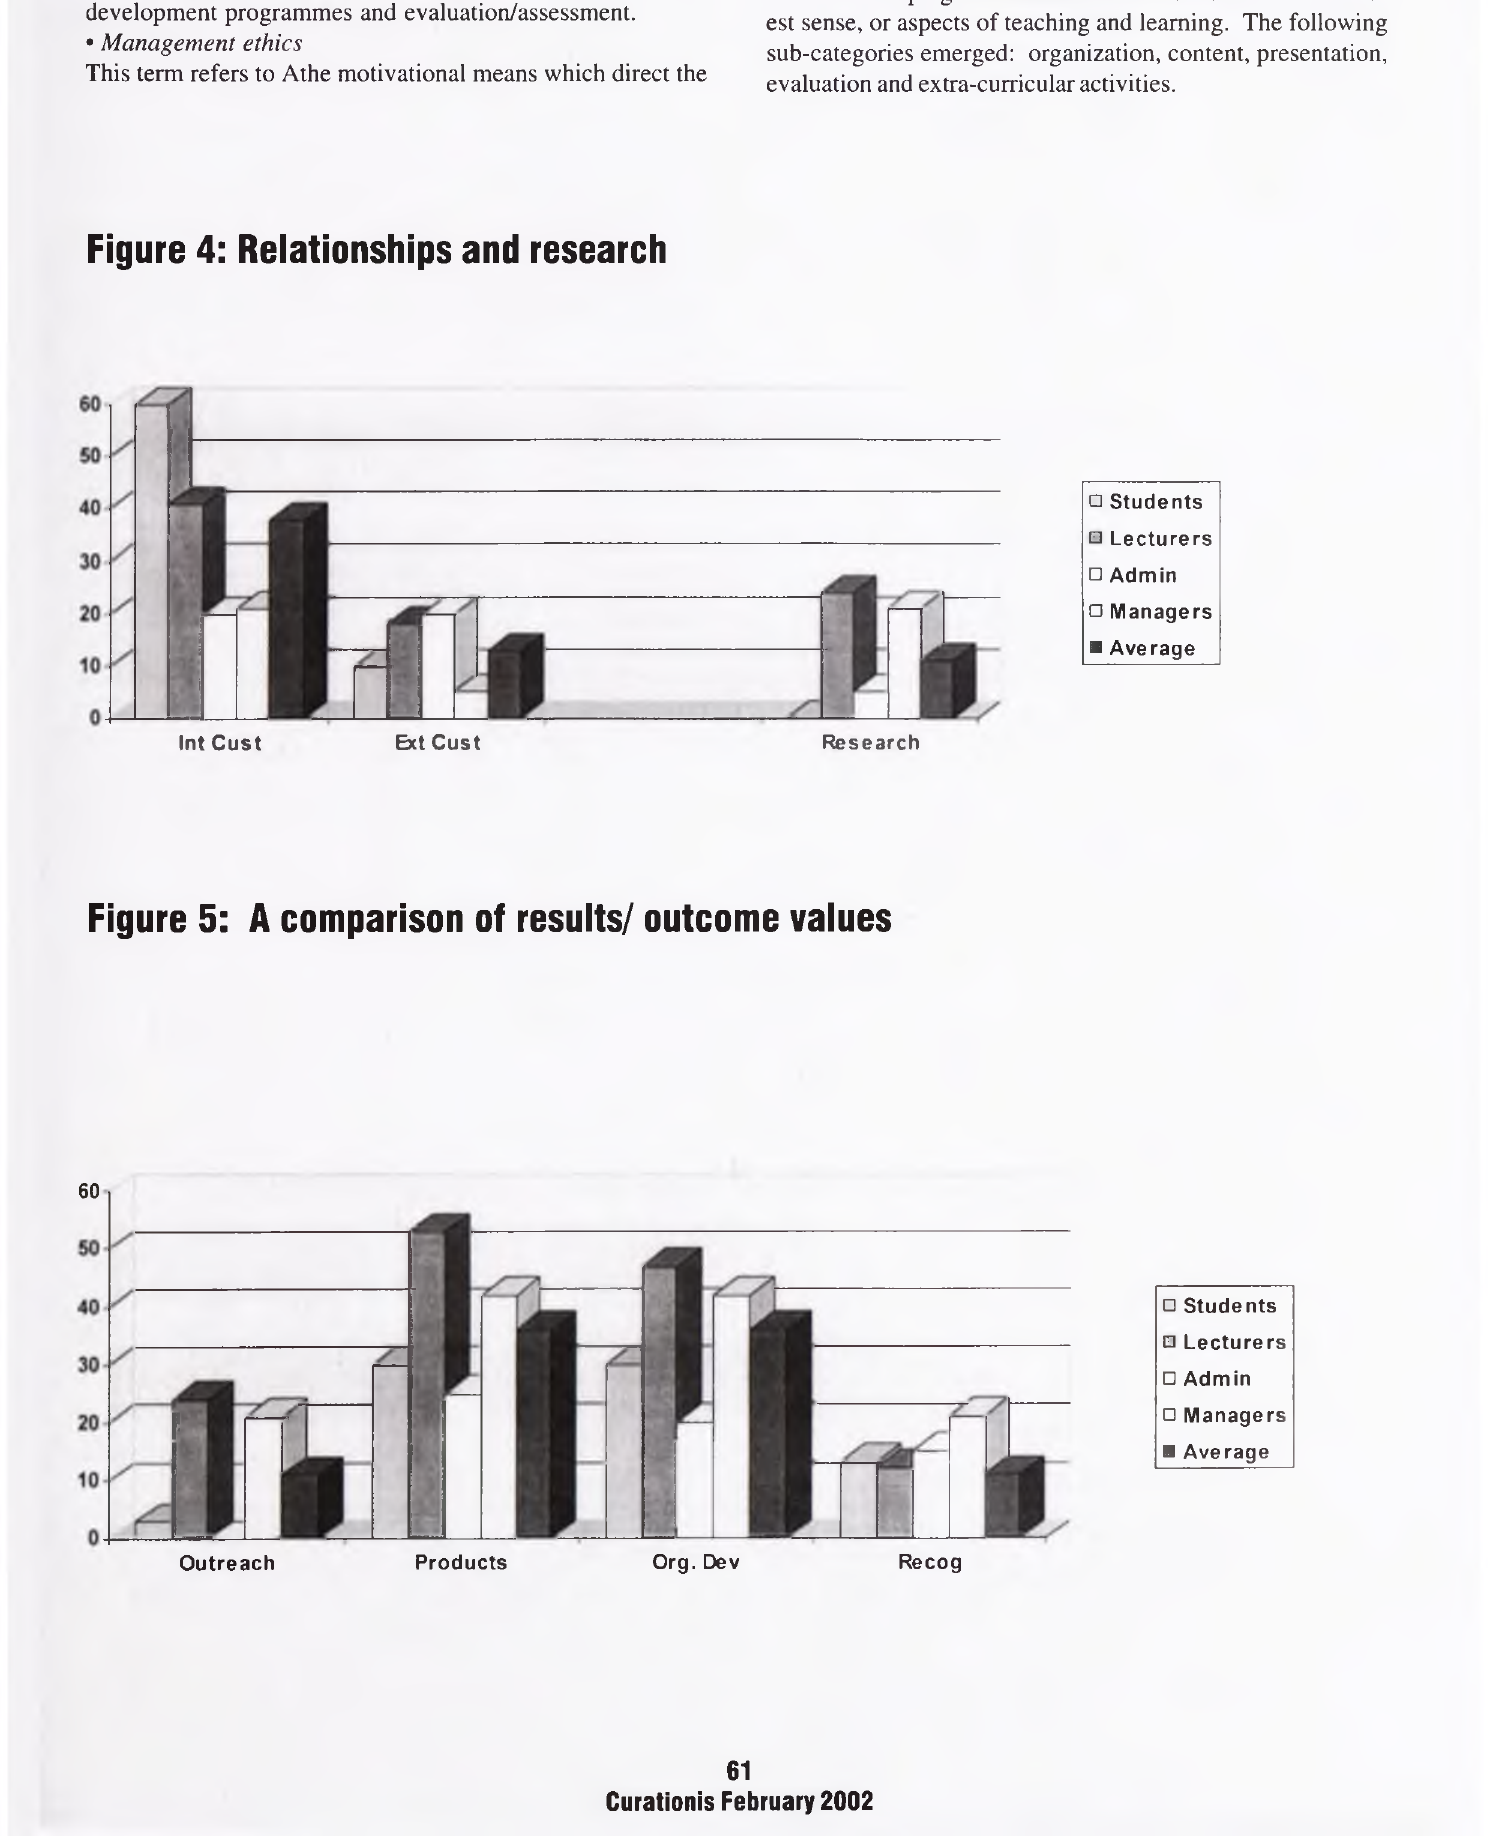
Figure 5: A comparison of results/ outcome